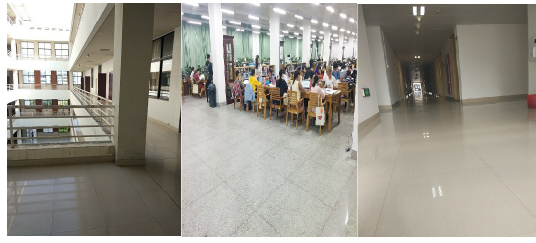
Figure 3. Different scenarios.